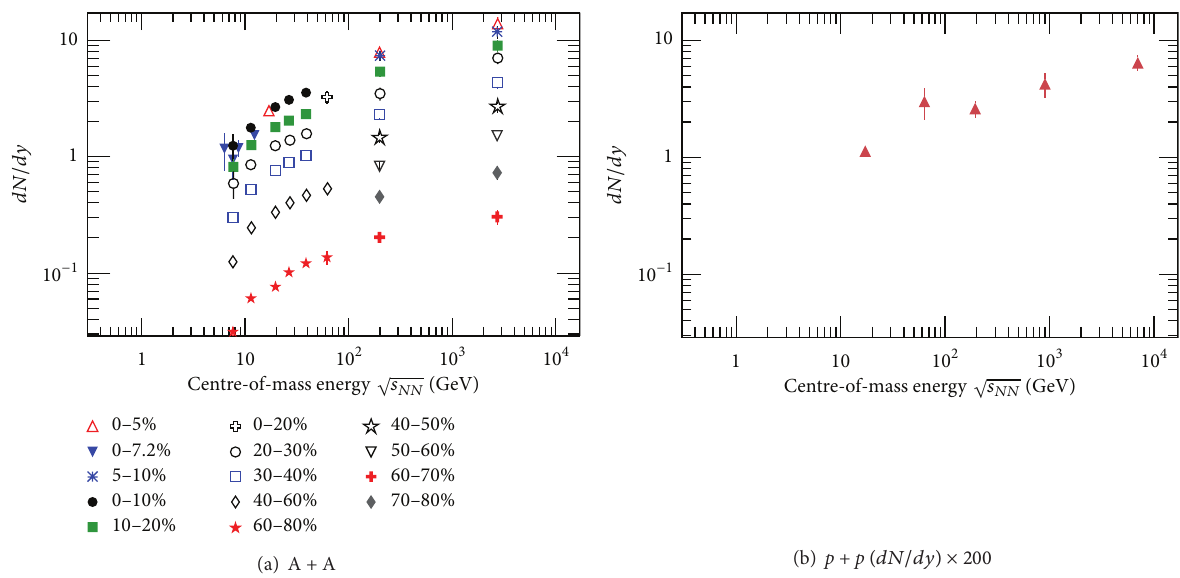
Figure 3: The 𝜙 meson midrapidity yield (𝑑𝑁/𝑑𝑦) as a function of √𝑠 𝑁𝑁 for A + A [16–18, 21] and 𝑝 + 𝑝 collisions [18–20, 22, 23]. For RHIC BES energies (√𝑠 𝑁𝑁 = 7.7 – 39 GeV ) only statistical errors are shown whereas for other energies systematic errors are added in quadrature with statistical